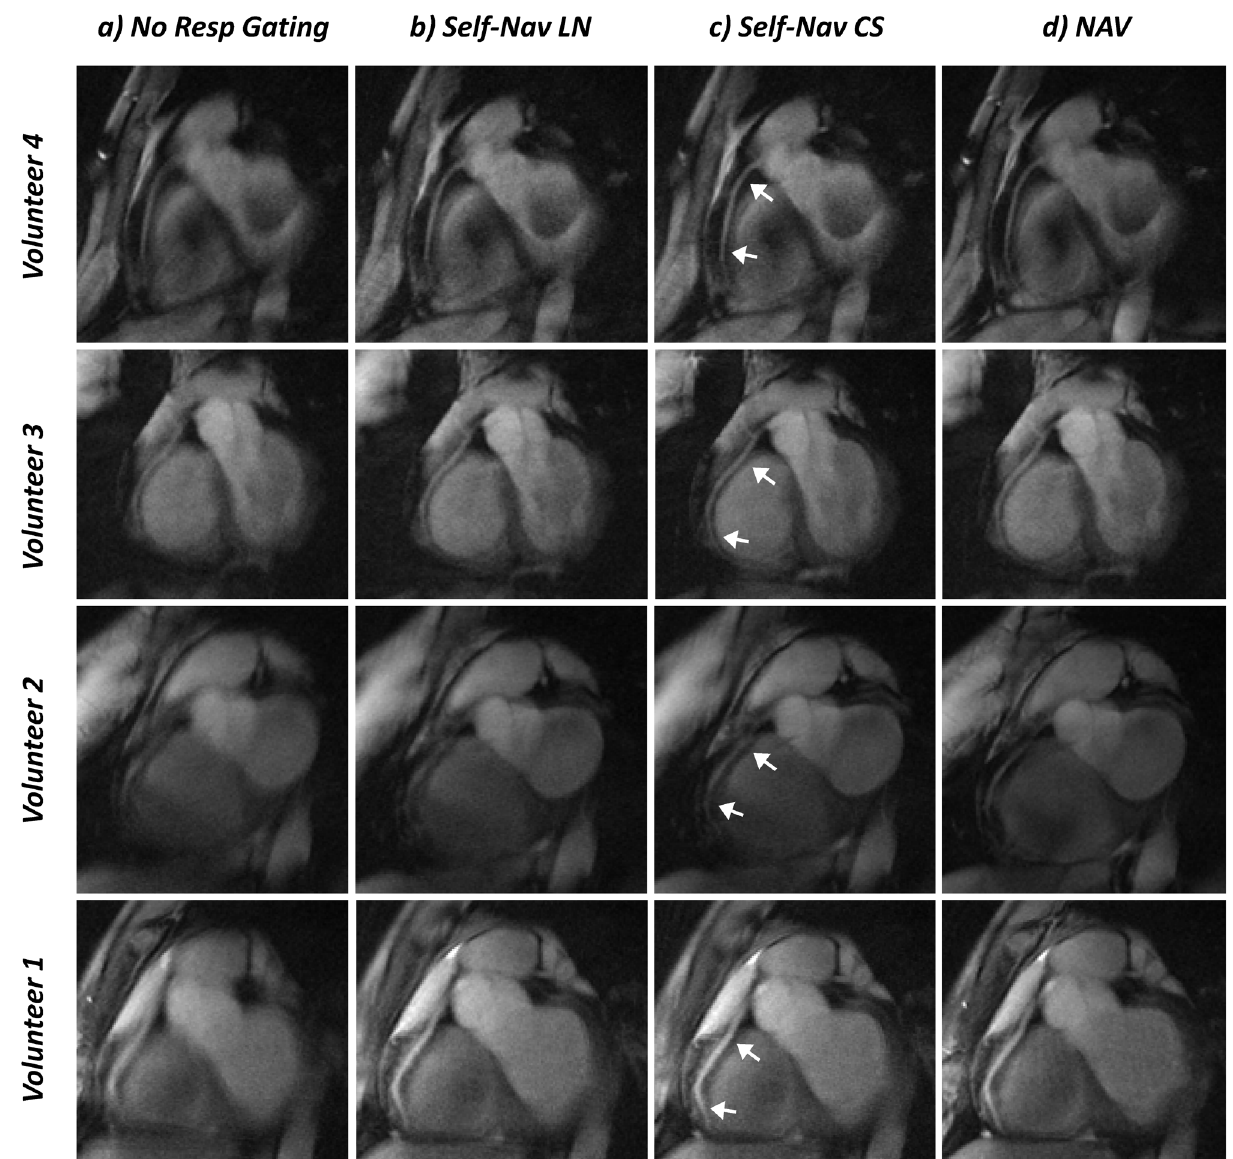
Figure 4. In vivo results from four healthy volunteers. a) Respiratory motion corrupted images from targeted acquisitions of the right coronary artery (RCA) without any respiratory gating. The images appear blurred and the RCAs not well depicted. When the same image data are retrospectively motion compensated using self-navigation with linear reconstruction (Self-Nav LN) of the sub-images (b), motion artifacts are suppressed and the anatomy is restored in the image with improved visibility of the RCA. c) Self-navigation with non linear reconstruction of the sub- images (Self-Nav CS) provides an improved image quality with better coronary delineation (arrows) when compared to the images obtained with the No Resp Gating and Self-Nav LN methods. The overall image quality approaches that of the standard of reference NAV acquisition in (d), albeit with a 2.8-fold reduction in scanning time.